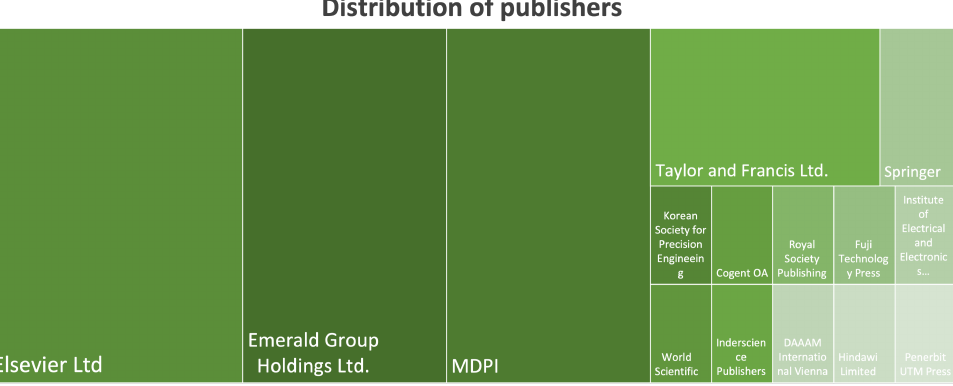
Figure 4. The figure presents the occurrence of the publication years within the examined period.